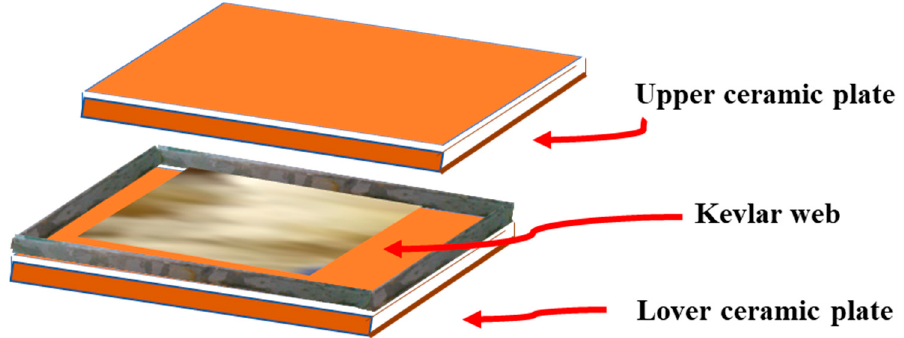
Figure 2. Schematic for mould and fabrication of composites.